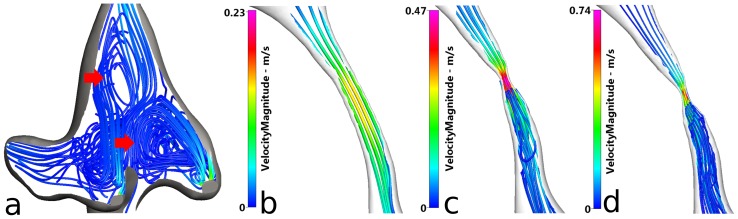
Velocity streamlines of the fourth ventricle and three cases of aqueductal stenosis (open, mild and severe).(a) View of the velocity streamlines of the aqueduct and fourth ventricle in a healthy patient in the sagittal plane. Two vortices are identified via the red arrows. (b) A more focused representation of the velocity streamlines of the aqueduct in a healthy patient. (c) Velocity streamlines of the mildly stenosed aqueduct. (d) Velocity streamlines of the severely stenosed aqueduct. CFD-VIEW was used to obtain all streamlines. All plots taken at t = 15s.